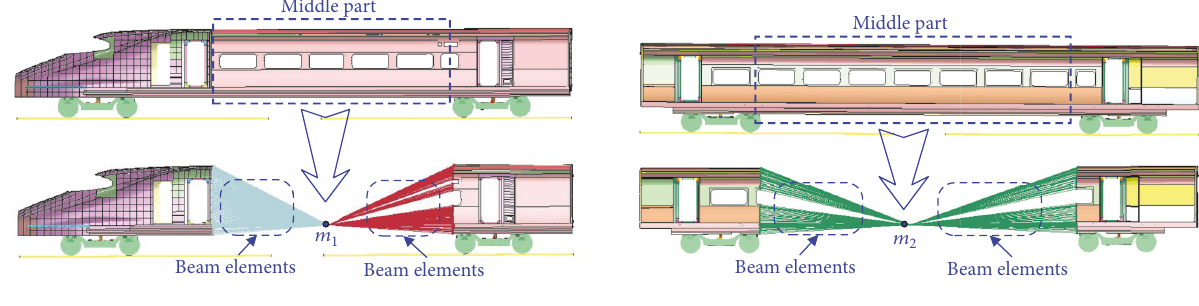
Figure 1: Simplification processes: head and intermediate railway vehicles. Table 1: Comparison of the grid scale of the whole train before, and after, simplification. Number of nodes Number of elements Number of beam elements Before simplification 4085296 4759820 - After simplification 2588860 2930082